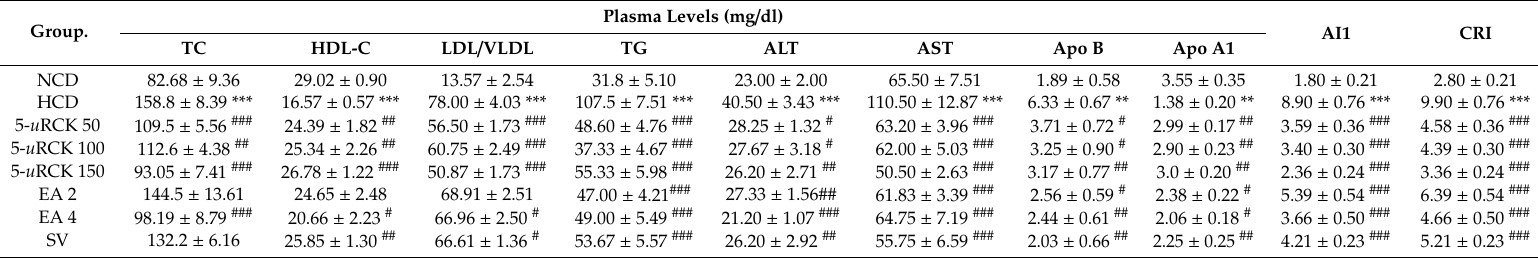
Table 4. Changes in the serum biochemistry profiles, atherogenic index (AI), and cardiac risk index (CRI) determined from the sera of 5- u RCK-treated, ellagic acid-treated, or simvastatin-treated high-cholesterol diet (HCD)-fed rats. ** p < 0.01, *** p < 0.001 versus control (NCD) group, # p < 0.05, ## p < 0.01, and ### p < 0.001 versus the HCD group. All data are shown as the mean ± SD ( n = 6–8).